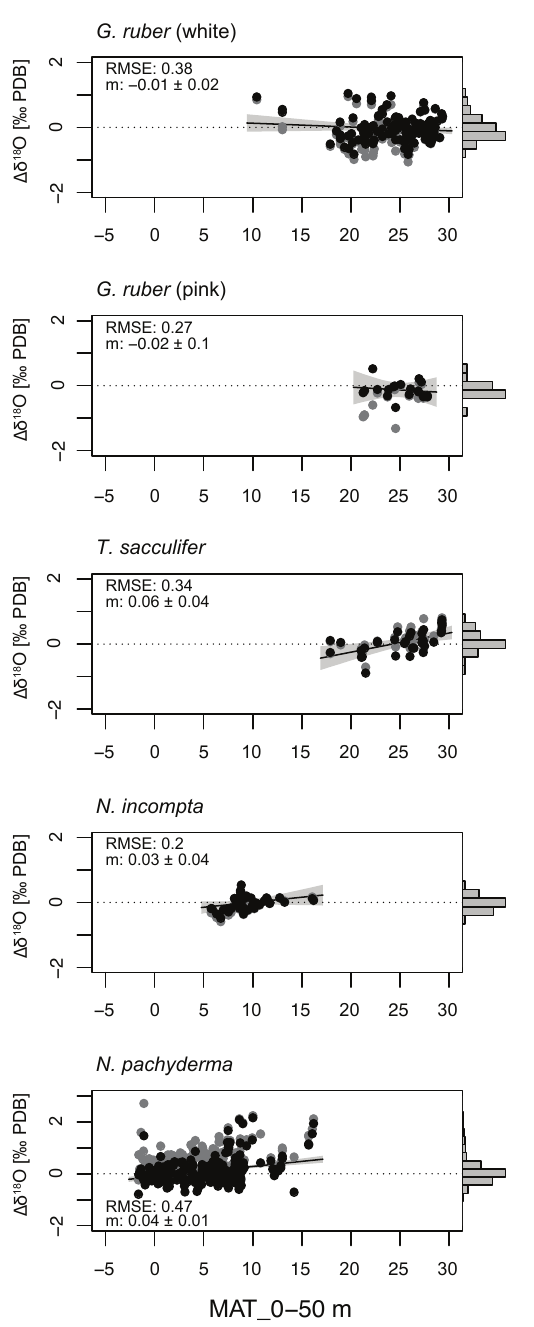
Figure 6. Offset between seasonality- and depth-adjusted δ 18 O eq and δ 18 O foram . In most cases both the RMSEs and the (cid:49)δ 18 O– temperature slopes are reduced, indicating further improvement in the prediction of foraminifera δ 18 O and suggesting that the sim- ple empirical parametrisation of habitat variability can be used to correct for habitat tracking. Grey symbols represent (cid:49)δ 18 O season ; error envelopes as in Fig.